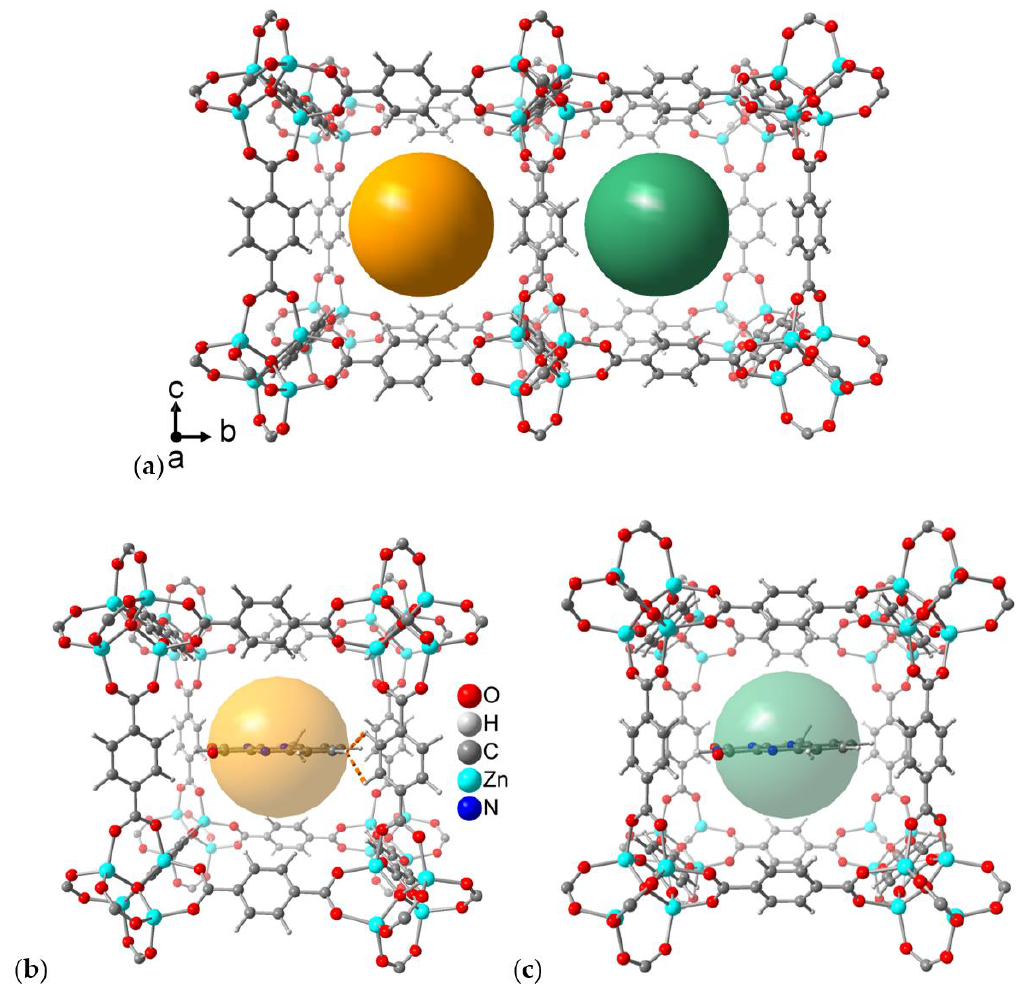
Figure 9. ( a ) Alternating neighboring pores in MOF-5 with different cages for binding MIA. Orange pore at left: Linker phenyl hydrogens face inwards toward the center of the pore. Green pore at right: outward position of linker phenyls. ( b ) Computed MIA molecule in the inward -cage in MOF-5 with the only two supramolecular contacts below 3.0 Å (two C-H···H-C contacts) indicated as dashed orange lines. ( c ) Computed MIA molecule in the outward -cage for which there are no supramolecular contacts below 3.0 Å .